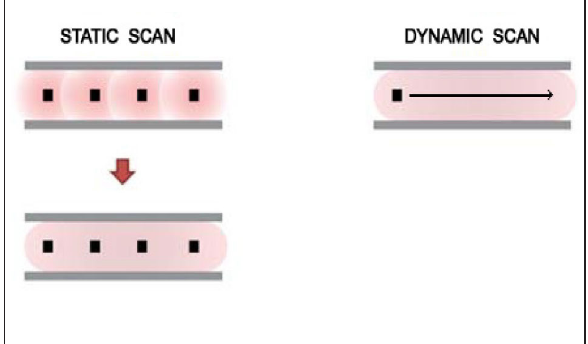
Figure 13. Differences between static laser scanner captures and TIMMS captures